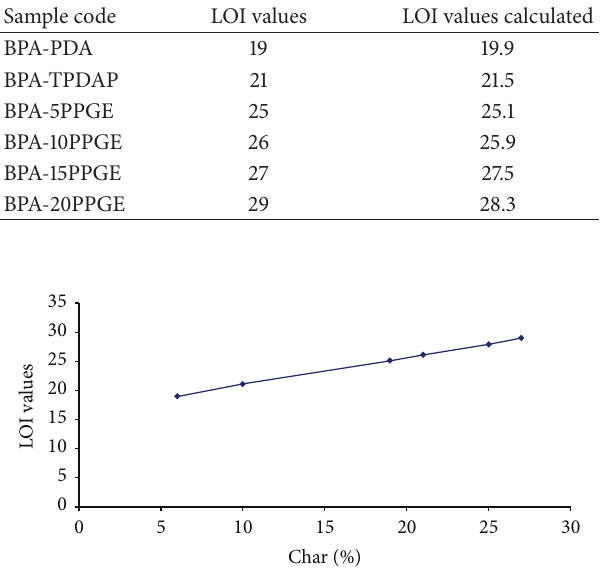
Figure 8: The plot of the epoxy resins’ char yields versus LOI values. ThestraightlinerepresentsKrevelen’sequation:LOI = 17.5+0.5 (𝜎)